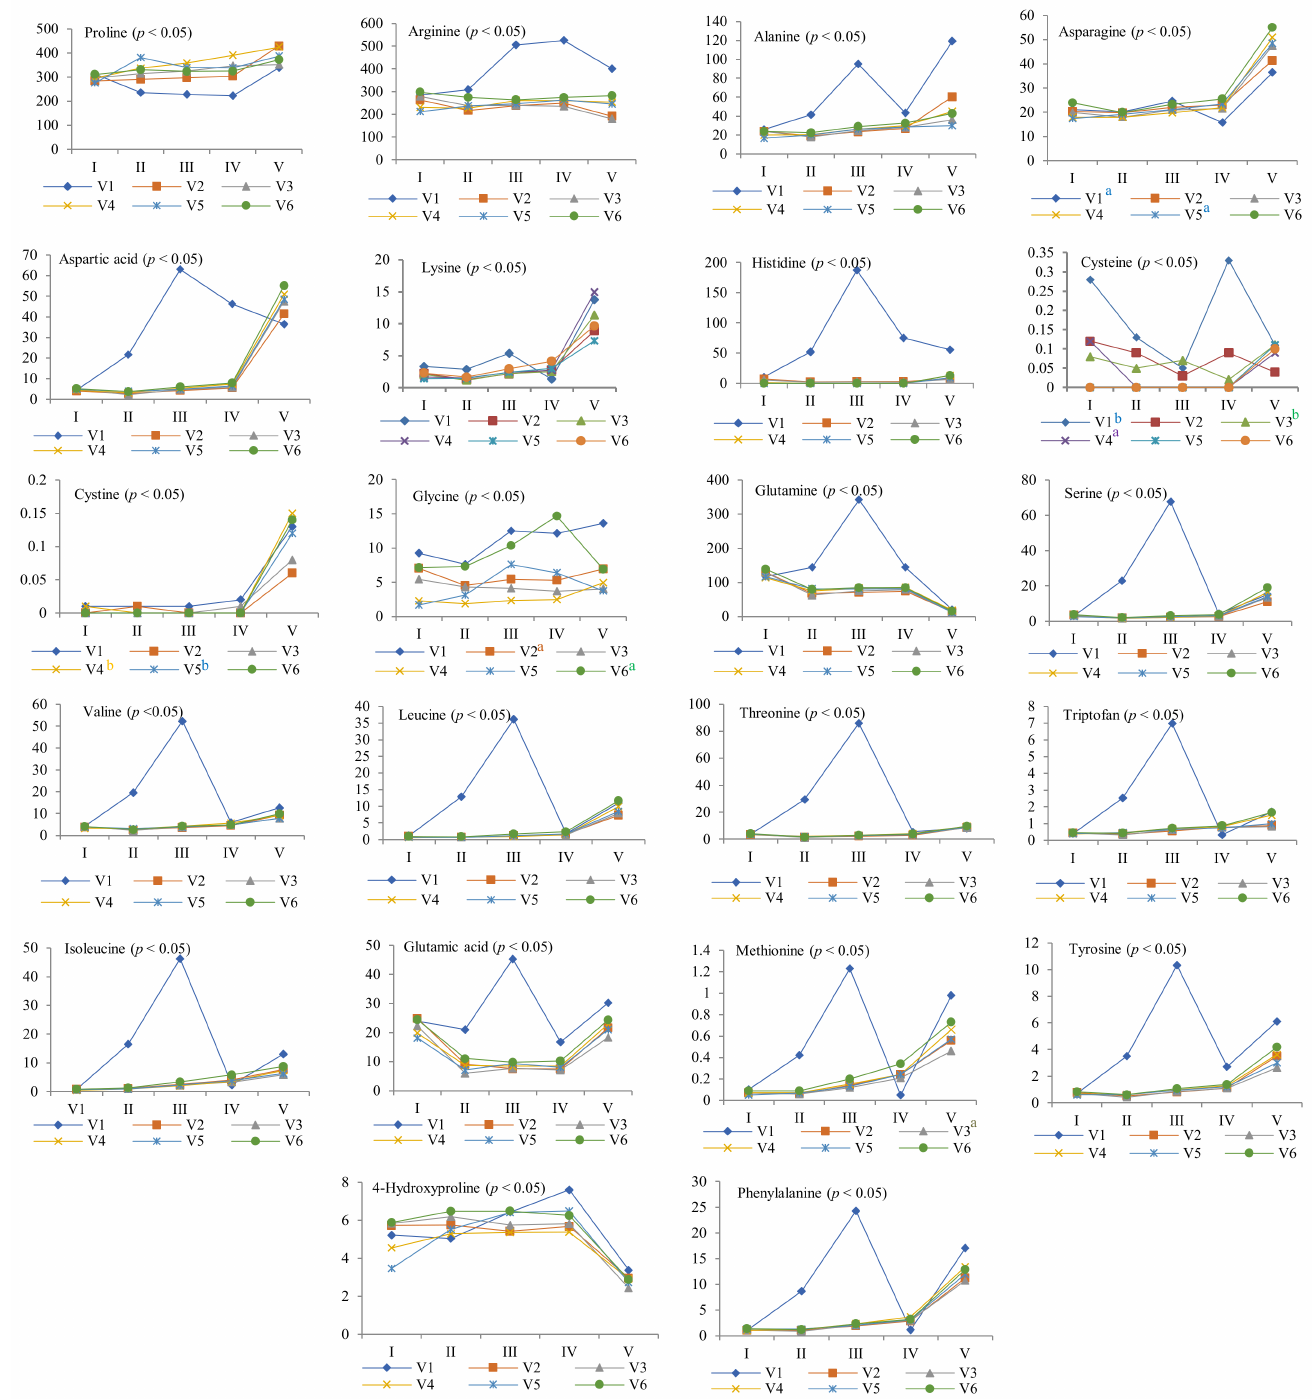
Figure 2. The influence of enzymatic treatments on the evolution of amino acids during the fermenta- tion of Feteasc ă regal ă samples (mg/L). I, II, III, IV—fermentation stage (ziua 1, 3, 6, 9); V—Final sam- ple (stabilized wine); V1—Endozym Thiol ® , AEB; V2—Endozym β -Split ® , AEB; V3—Zymovarietal aroma G ® , SODINAL; V4—Endozym Ice ® , AEB; V5—Zimarom ® , BSG WINE; V6—control sam- ple, no enzymes. The superscript letters indicate homogeneous groups, between which there is no statistically significant difference ( p > 0.05), in correlation with the Fisher LSD